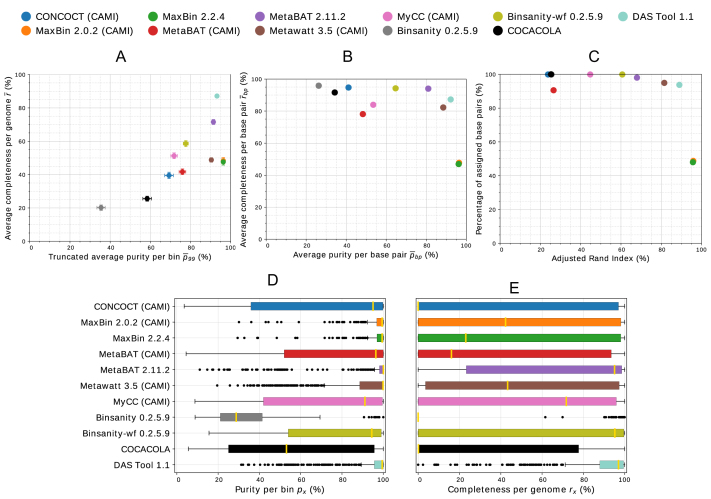
Assessment of genome bins reconstructed from CAMI's high-complexity challenge dataset by different binners. Binner versions participating in CAMI are indicated in the legend in parentheses. (A) Average purity per bin (xaxis), average completeness per genome (yaxis), and respective standard errors (bars). As in the CAMI challenge, we report \documentclass[12pt]{minimal}
\usepackage{amsmath}
\usepackage{wasysym} 
\usepackage{amsfonts} 
\usepackage{amssymb} 
\usepackage{amsbsy}
\usepackage{upgreek}
\usepackage{mathrsfs}
\setlength{\oddsidemargin}{-69pt}
\begin{document}
}{}${\bar{p}_{99}}$\end{document} with 1% of the smallest bins predicted by each program removed. (B) Average purity per base pair (xaxis) and average completeness per base pair (yaxis). (C)ARI per base pair (xaxis) and percentage of assigned base pairs (yaxis). (D and E) Box plots of purity per bin and completeness per genome, respectively.